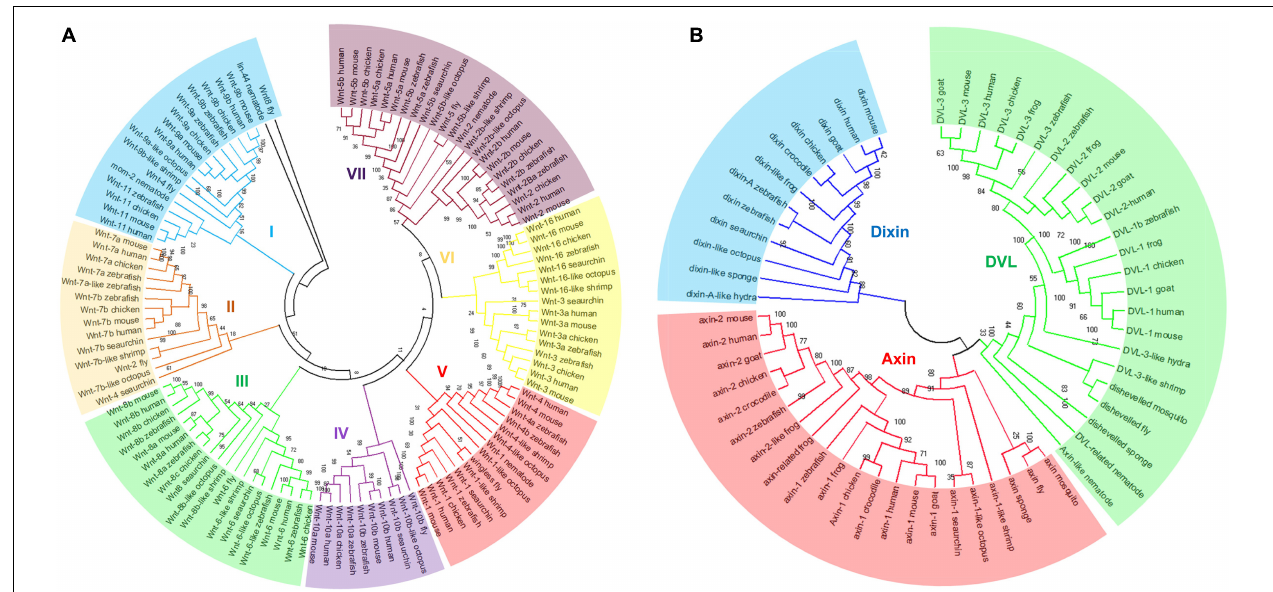
FIGURE 3 | Phylogenetic classification of Wnt and DIX proteins. The phylogenetic trees of Wnt (A) and DIX (B) were built through the neighbor-joining (N-J) method with 1000 bootstrap replicates. All Wnt proteins from different species were divided into seven groups, and the DIX proteins were divided into three major groups. Both of these major groups are highlighted in different